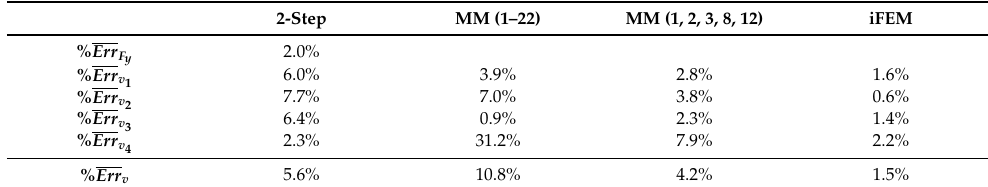
Table 3. Absolute value of the percent errors of the reconstructed quantities averaged over the three